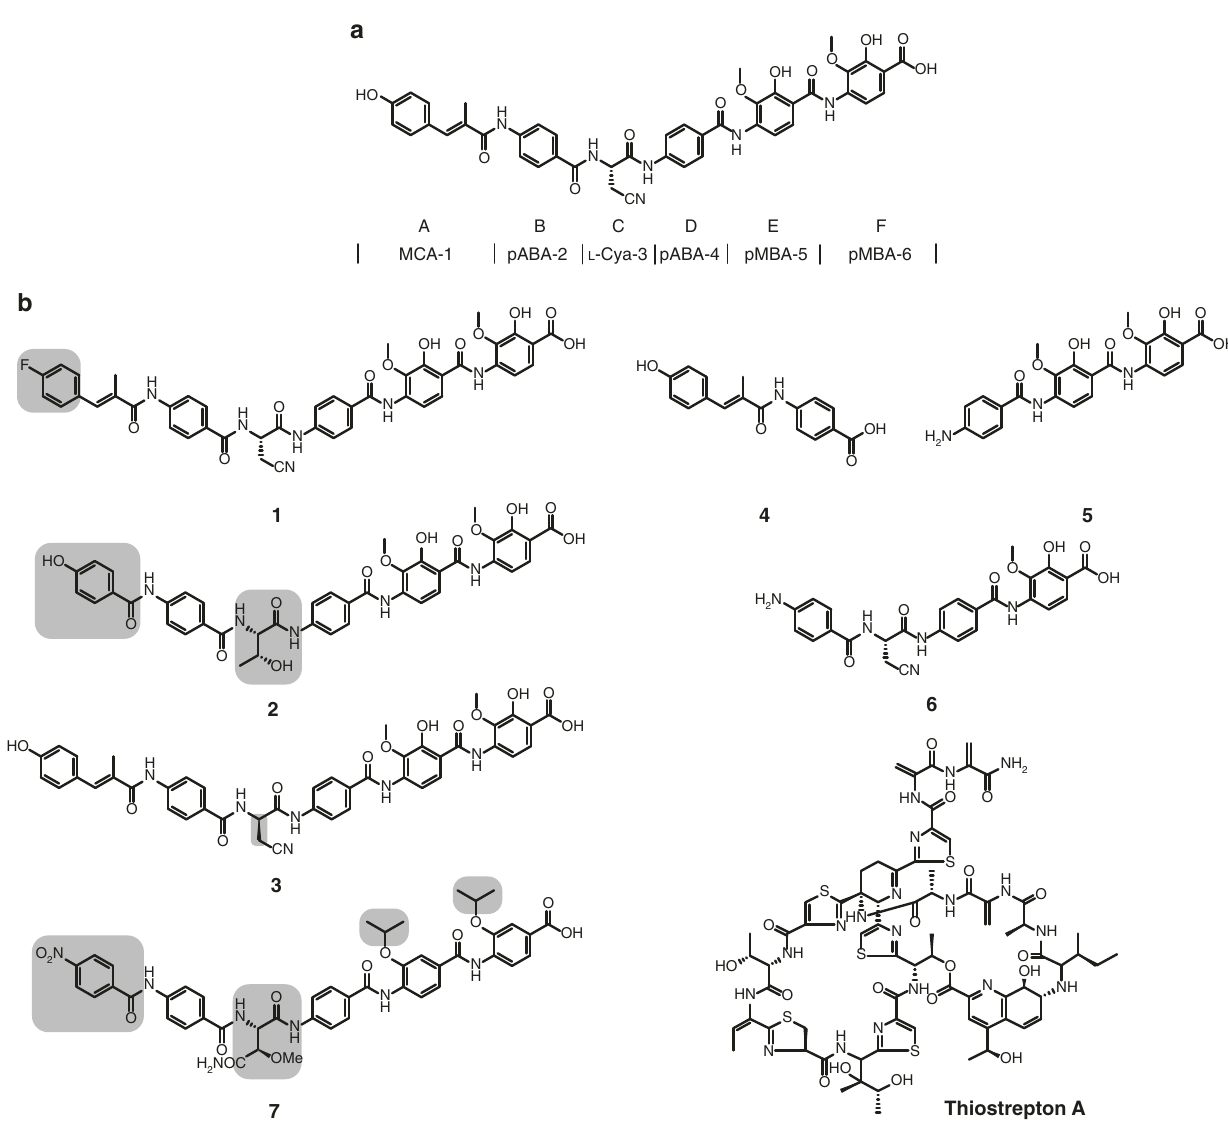
Fig. 1 Structure of albicidin. a Albicidin is composed of six building blocks (denoted A – F): p -coumaric acid (MCA-1); p -aminobenzoic acid ( p ABA-2 and p ABA-4); non-proteinogenic α -amino acid L -Cya-3; and two 4-amino-2-hydroxy-3-methoxybenzoic acids ( p MBA-5 and p MBA-6). b Overview of tested compounds. Structural variations with respect to albicidin are highlighted